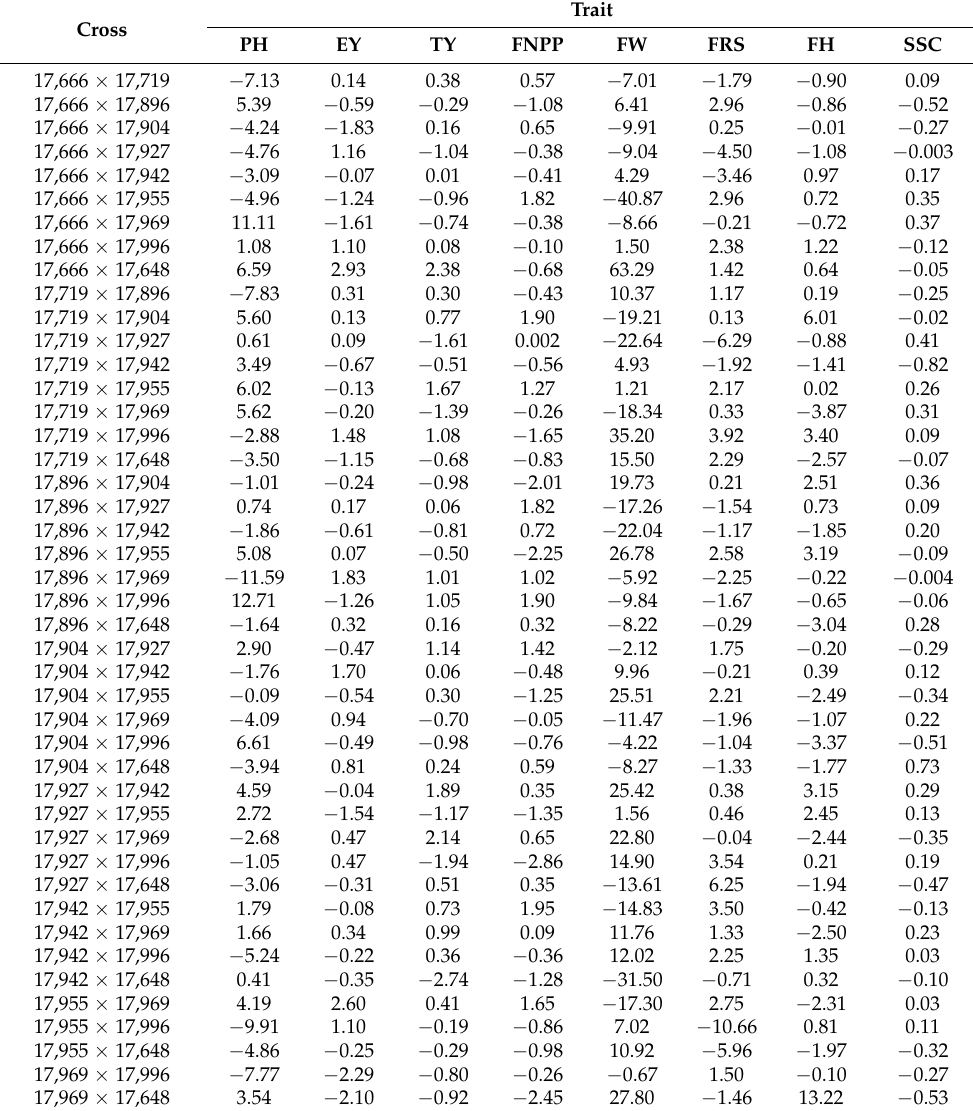
Table 5. Specific combining ability (SCA) effects of crosses for the eight main agronomic